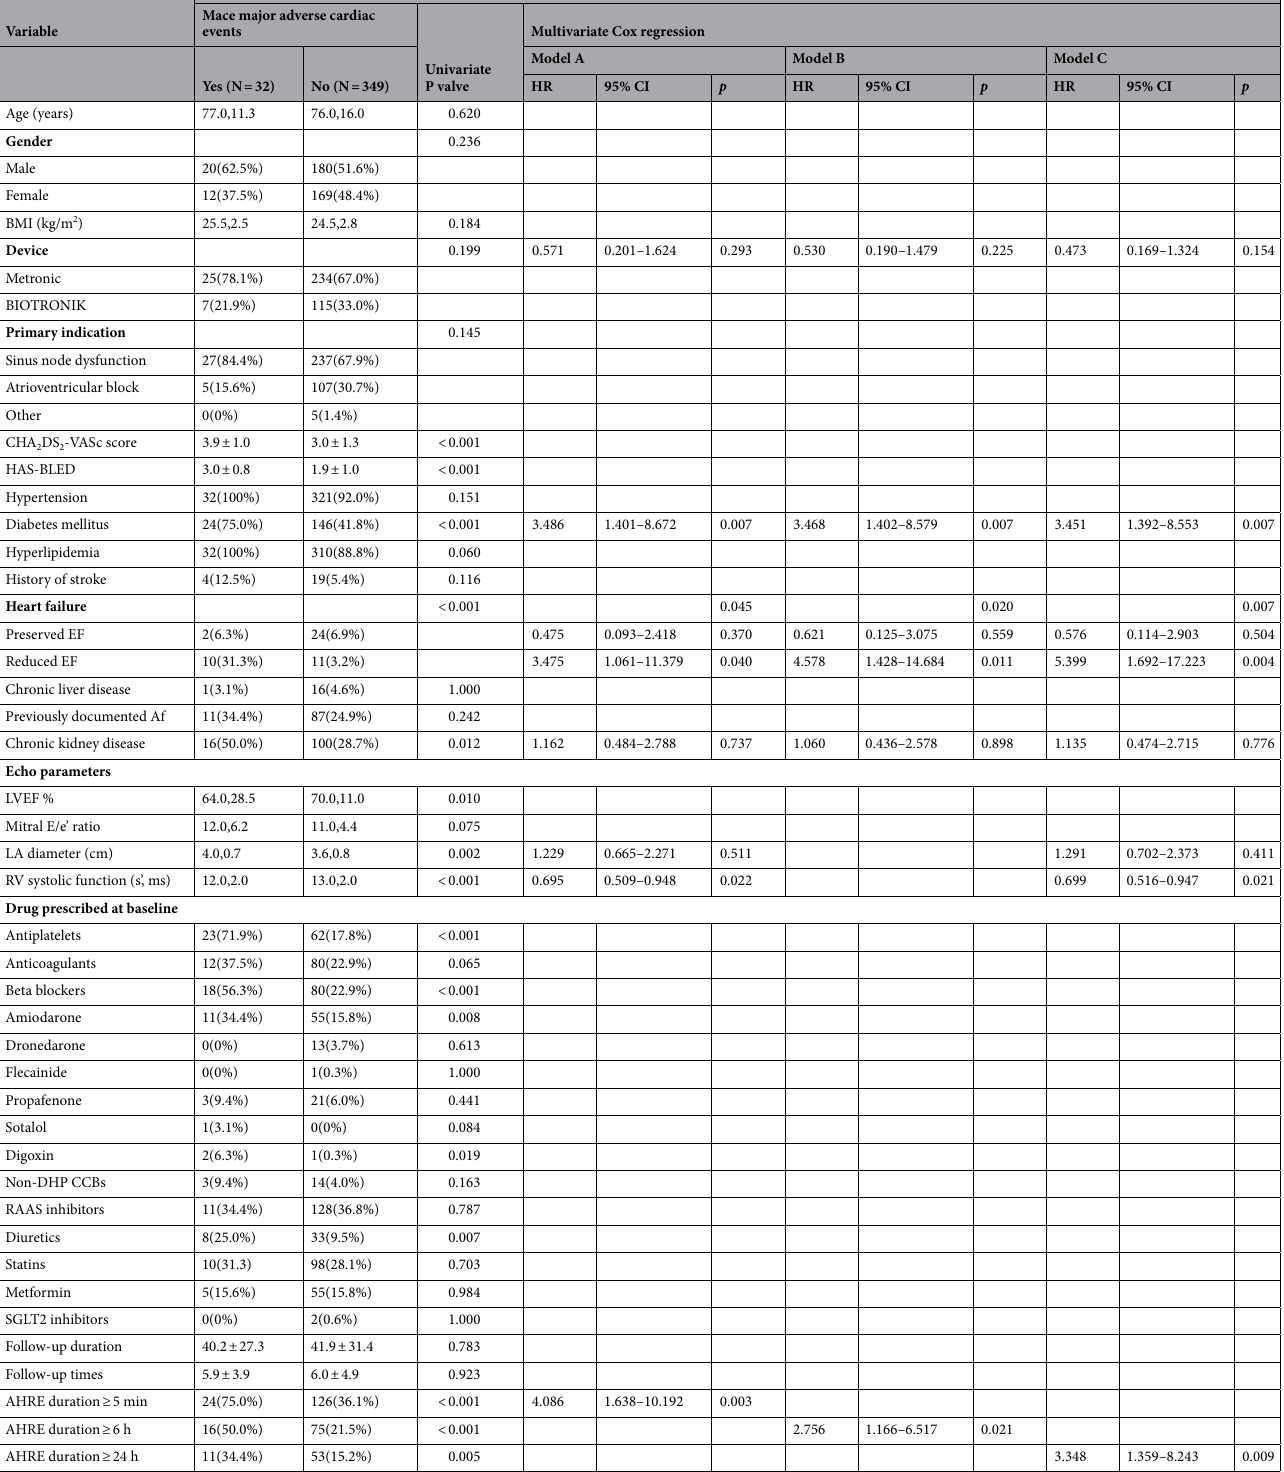
Table 6. Cox proportional hazard regression analysis with time-dependent covariates for MACE predictors in patients without history of myocardial infarction and with AHREs ≥ 5 min (Model A), ≥ 6 h (Model B), ≥ 24 h (Model C). Data are presented as mean ± SD or median, IQR or n (%). AF atrial fibrillation, AHRE atrial high-rate episodes, BMI body mass index, EF ejection fraction, IQR interquartile range, LA left atrium, LVEF left ventricular ejection fraction, RV right ventricle, non-DHP CCBs non-dihydropyridine calcium channel blockers, RAAS renin–angiotensin–aldosterone system, SGLT2 sodium glucose co-transporters